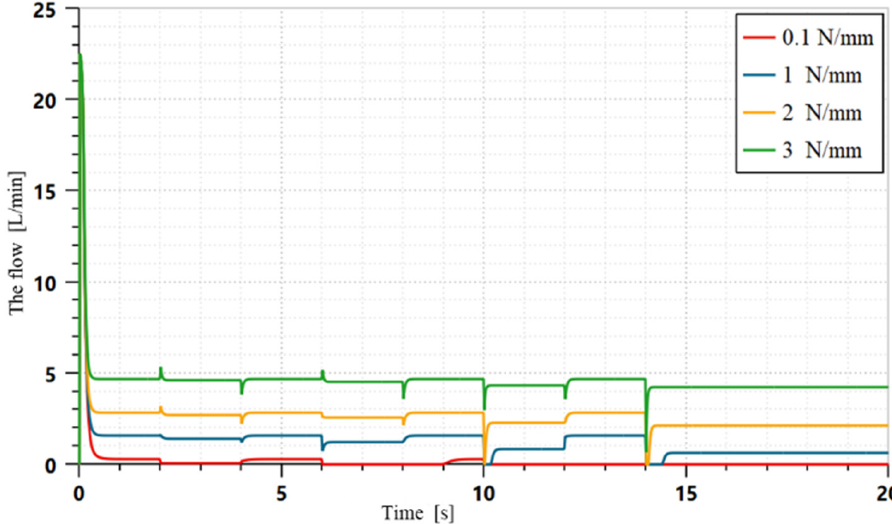
Figure 9. Flow-rate variation under spring stiffness from 0.1 N/mm to 3 N/mm.